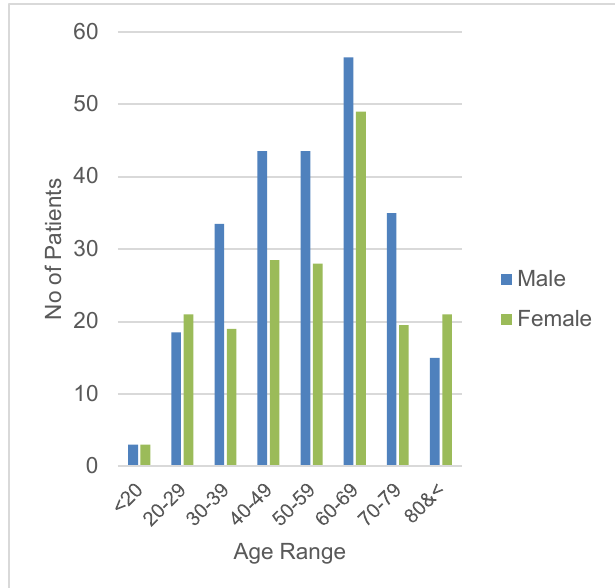
Fig1. Analysis of heart disease with respect to age group (2009),(https://www.researchgate.net/figure/Bar-chart-of- age- years-sex-distribution-of-patients-with-heart- failure_fig1_26831468.)